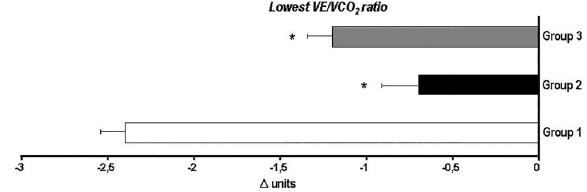
Figure 6. Absolute changes in ventilatory ef fi ciency among coronary artery disease patients after aerobic exercise training program. Group 1 (n=34, peak VO 2 o 17.5 mL (cid:3) kg – 1 (cid:3) min – 1 ; lowest VE/VCO 2 ratio 33.5); group 2 (n=67, peak VO 2 4 17.5 and o 24.5 mL (cid:3) kg – 1 (cid:3) min – 1 ; lowest VE/VCO 2 ratio 29.7) and group 3 (n=22, peak VO 2 4 24.5 mL (cid:3) kg – 1 (cid:3) min – 1 ; lowest VE/VCO 2 ratio 29.0). Note that group 1 showed a greater decrease in the lowest VE/VCO